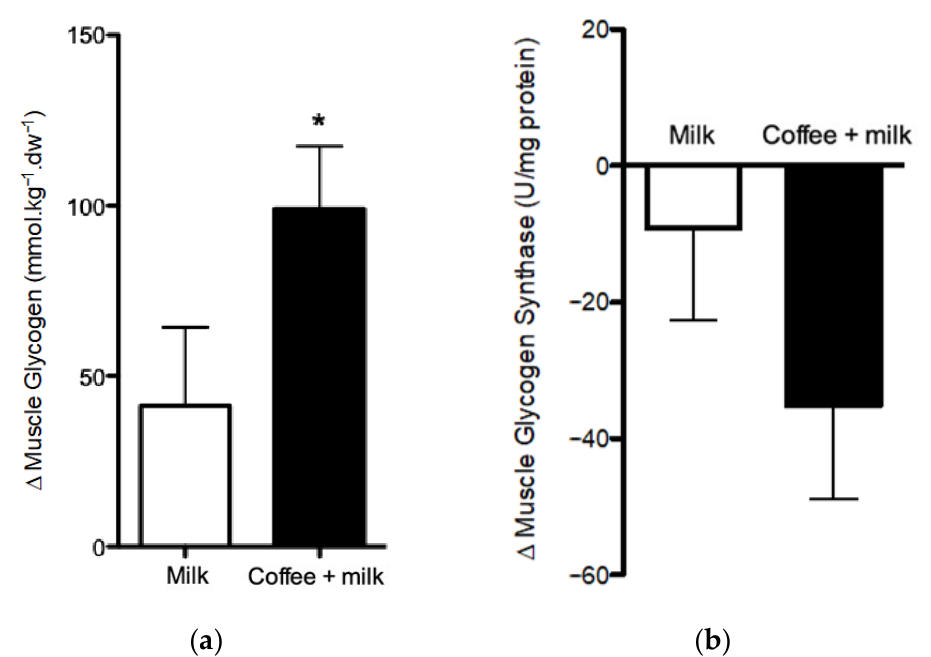
Figure 4. Muscle glycogen content ( a ) and Muscle glycogen synthase activity ( b ) in muscle of healthy endurance-trained adult men treated or not with coffee. Differences between 0 h and 4 h ( ∆ ) following cycling to volitional fatigue (70% PPO). * p = 0.01 for muscle glycogen content (Coffee + milk ∆ vs. Milk ∆ ). coffee + milk ∆ vs. milk ∆ for muscle glycogen synthase activity ( p = 0.22). Data are least square means + SE from repeated procedure method, Proc Mixed (SAS studio).